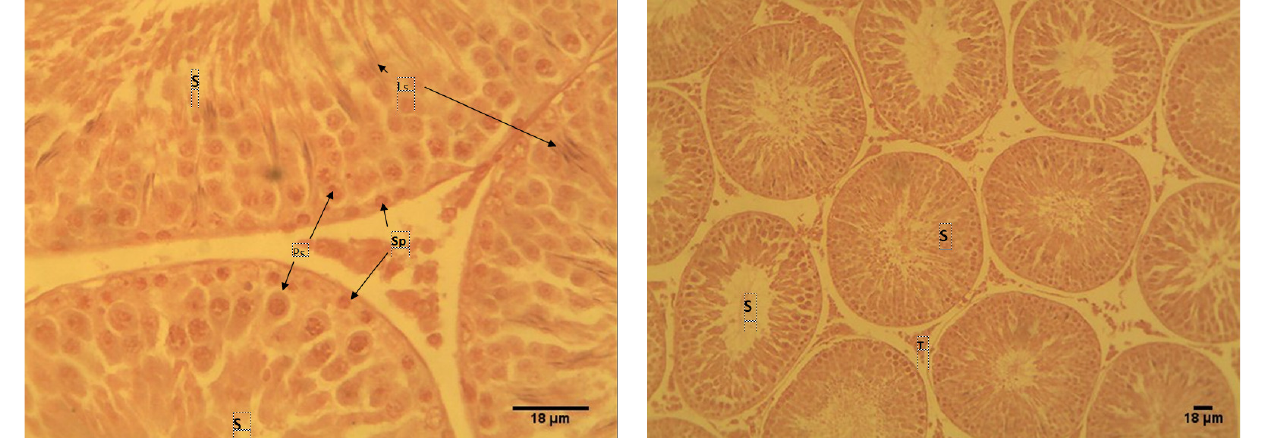
Fig. 2. Histological appearance of testis of rat given 0.5 mg/kg body weight of quail egg orally for 63 days, showing no obvious lesions. Note active seminiferous tubules (S) bearing spermatogonium